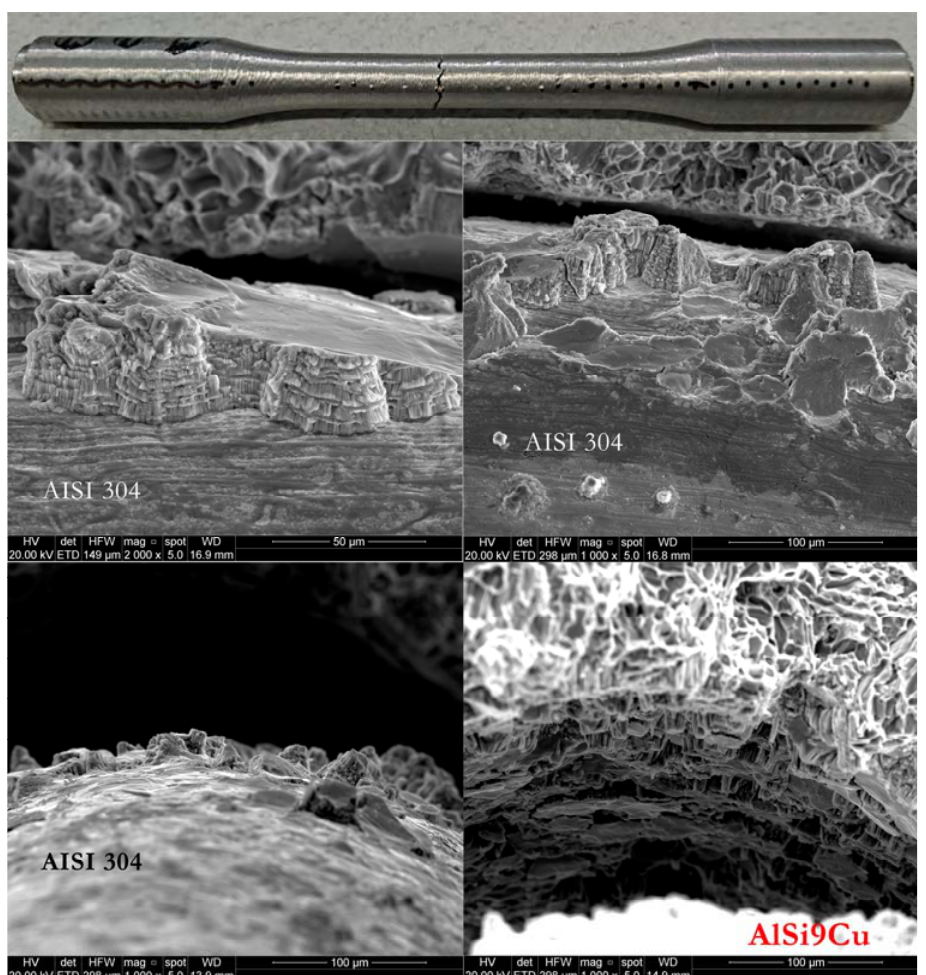
Figure 10: Broken sample in the as-cast condition and SEM micrographs of the Steel/Al interface after heat treated specimen